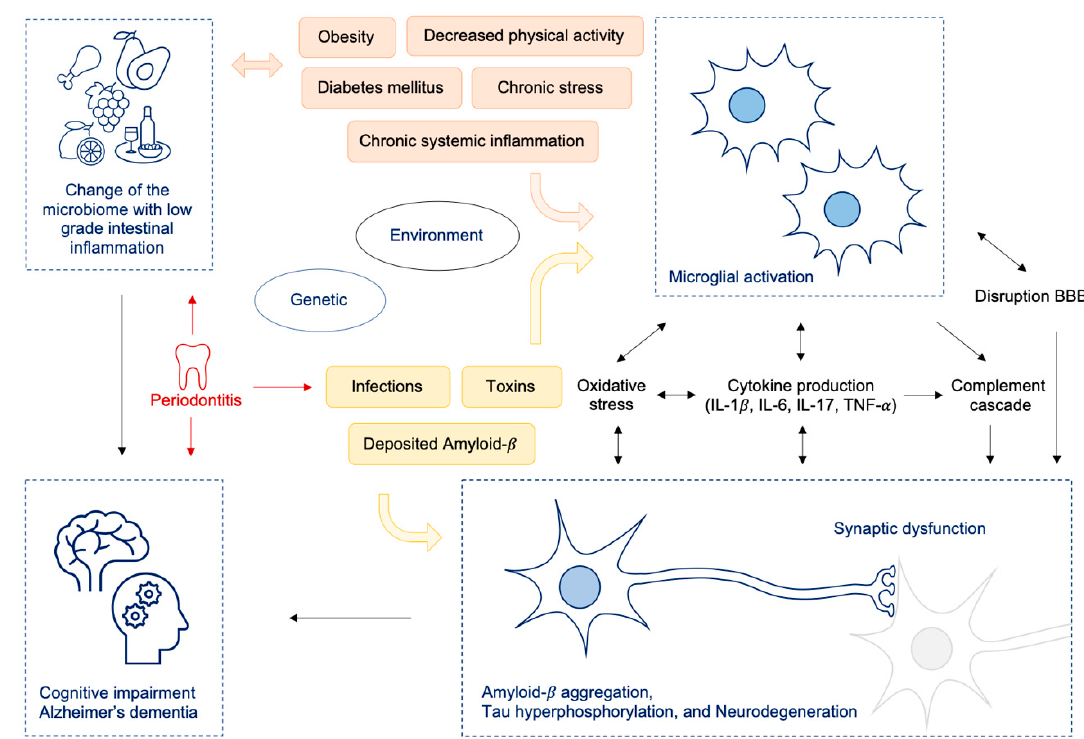
Figure 2. Change of the microbiome (e.g., by Western diet) resulting in intestinal dysbiosis leads to low grade inflammation in the gut and to increased intestinal and BBB permeability and consecutively to neuroinflammation and cognitive decline; oral pathobionts like P. gingivalis lead to oralisation of gut microbiota on the one hand, thus additionally driving gut inflammation and on the other hand promoting neuroinflammatory processes by translocation of bacteria to the brain via toxic proteases. Abbreviations: IL = interleukin, TNF = tumor necrosis factor; BBB = blood brain